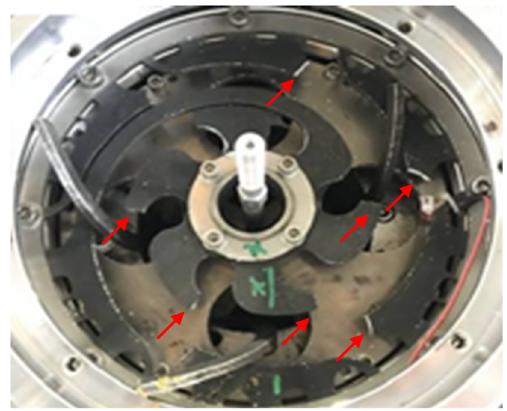
Figure 2. Conventionally designed spring break due to fatigue accumulation (red arrows: fractured points).